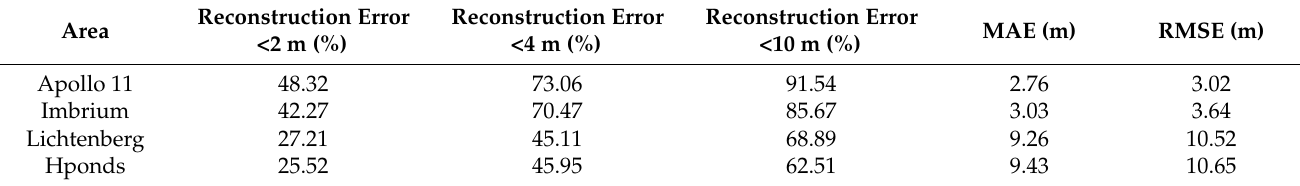
Table 2. The overall statistics of the reconstruction errors in the four